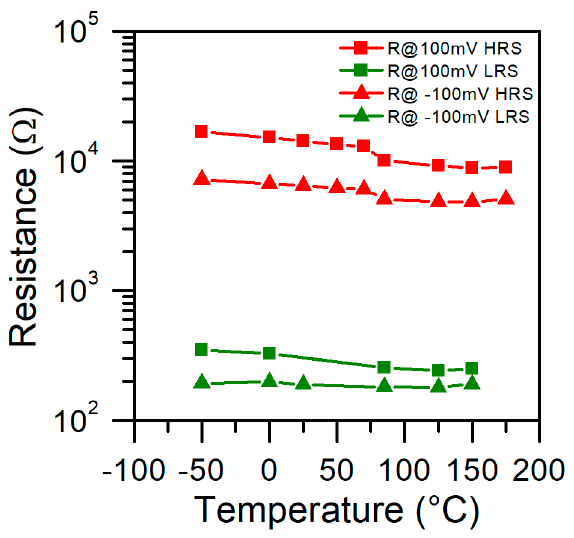
Figure 9. Differential resistance value of Al/SiO 2 /n++-Si RRAM device measured at various temper- atures and V = ± 100 mV for HRS and LRS.